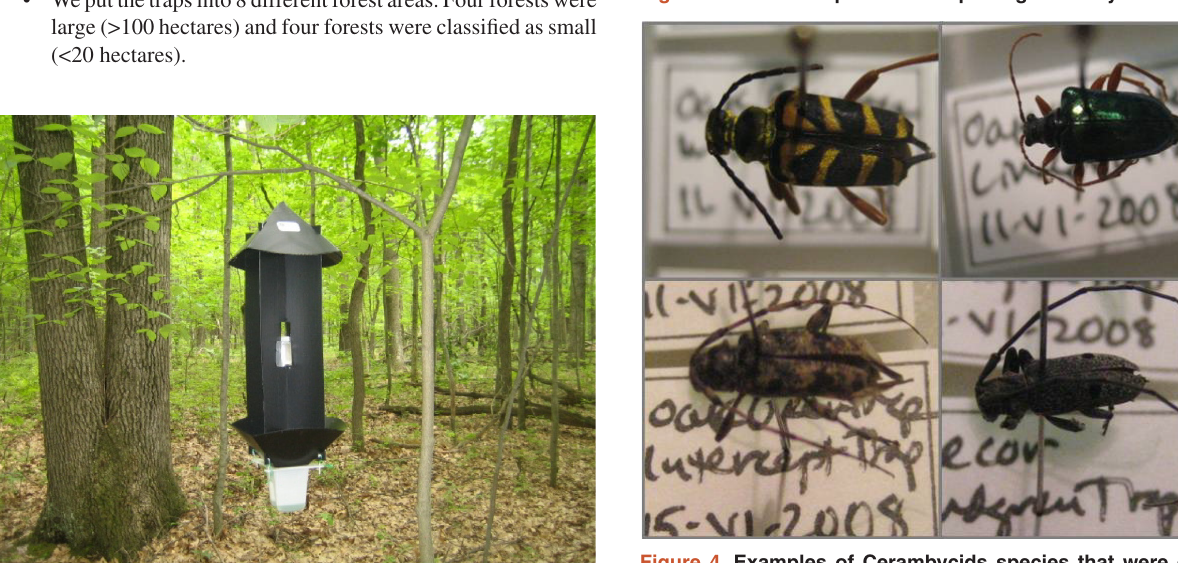
Figure 3. Window trap used for capturing Cerambycid beetles.